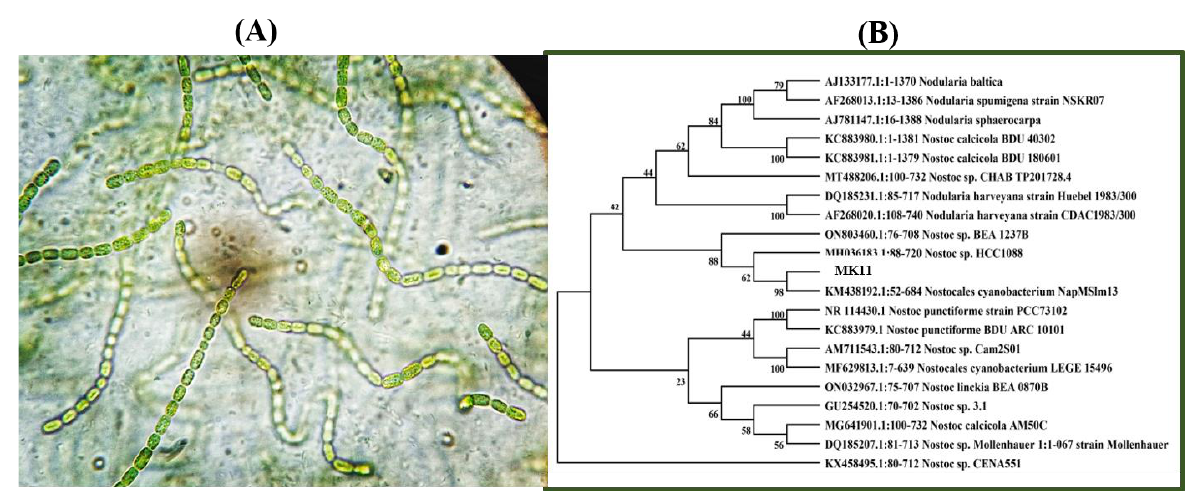
Figure 1. ( A ) Micrograph of cyanobacterium Nostoc sp. MK-11, ( B ) phylogenetic tree based on the 16s rRNA sequences of Nostoc sp. MK-11.